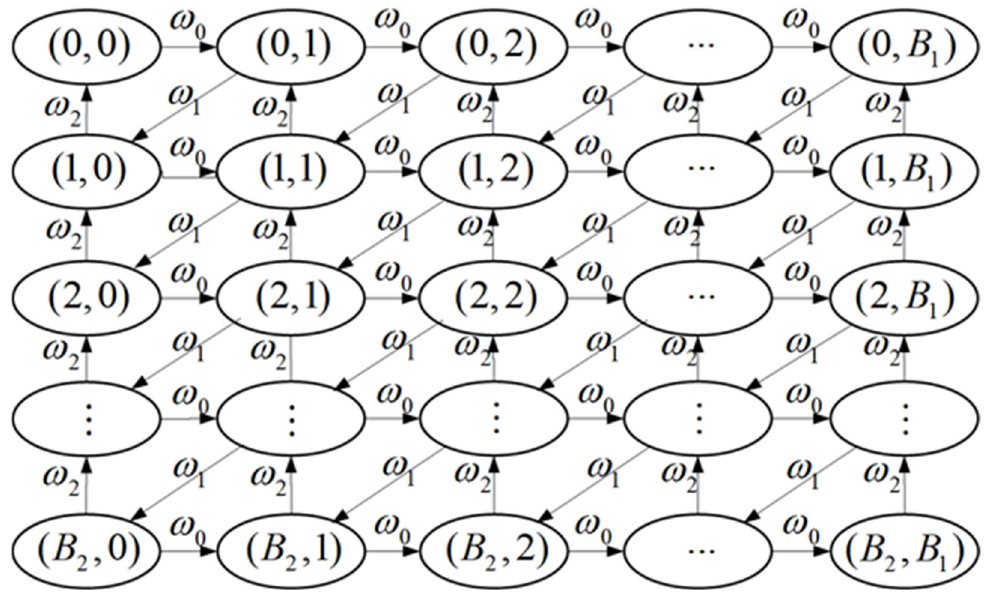
Figure 10. State-transition diagram of the buffer B 1 and B 2 .